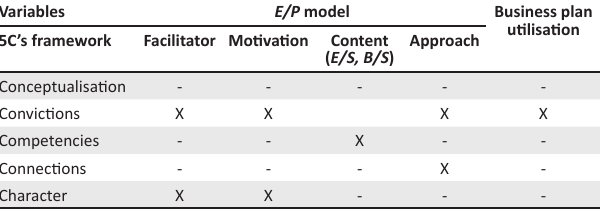
TABLE 3: Construct elements common to the 5C’s framework and entrepreneurial performance model.